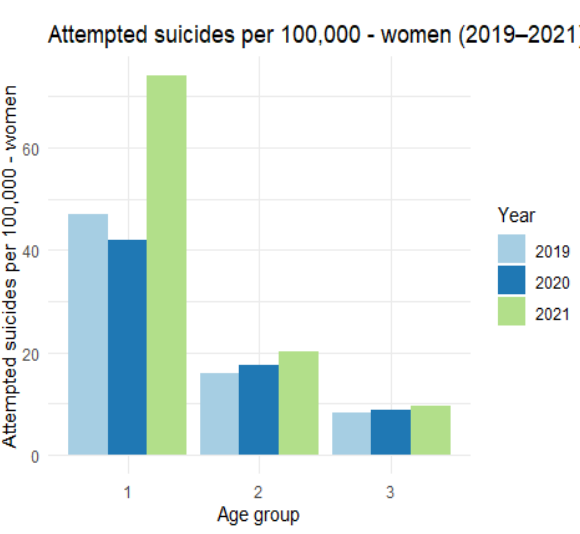
Figure 6. The number of attempted suicides per 100,000 women (2019–2021).